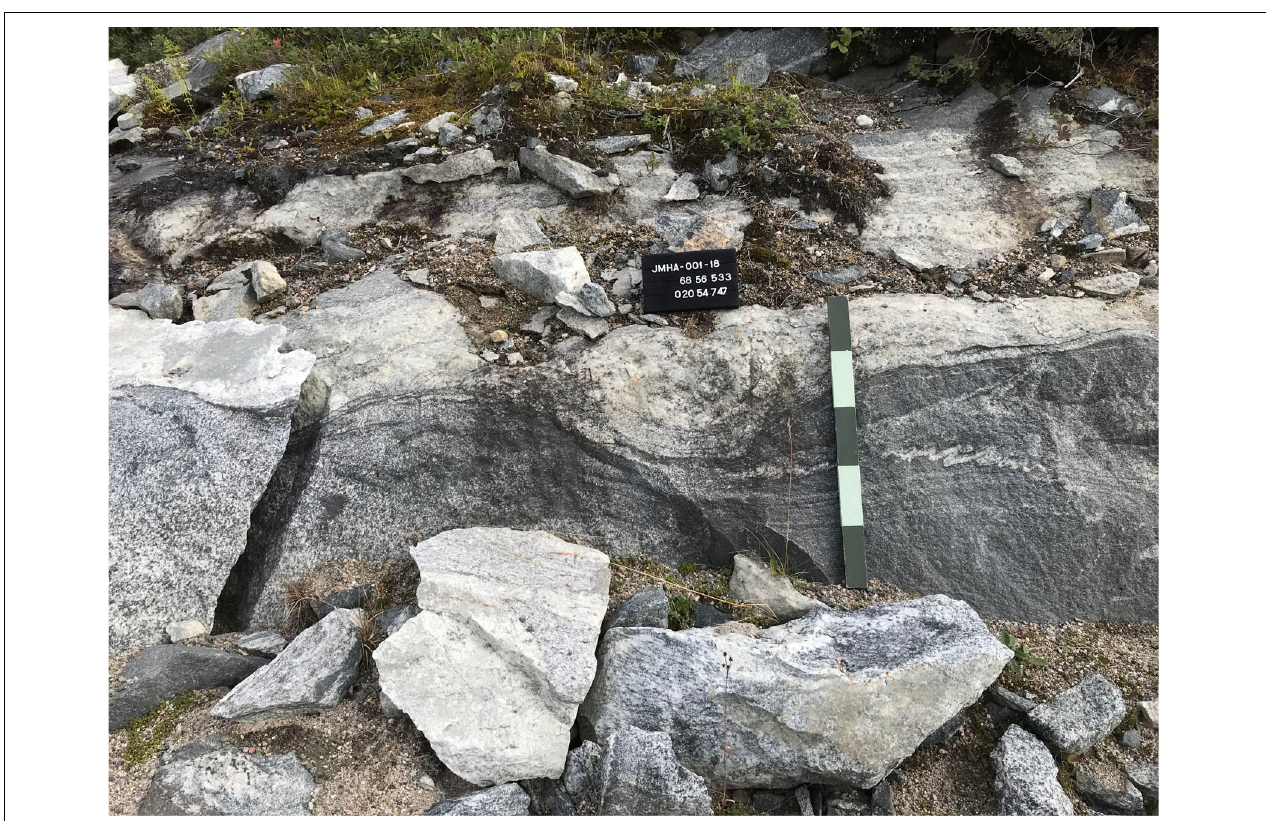
FIGURE 6 | Transition from amphibolite (right boudin) to nebulite (left boudin) in a coherent boudinage structure. Laassaniemi, NW Finland, Rommaeno Complex, Norrbotten Province. Length of scale 50 cm.